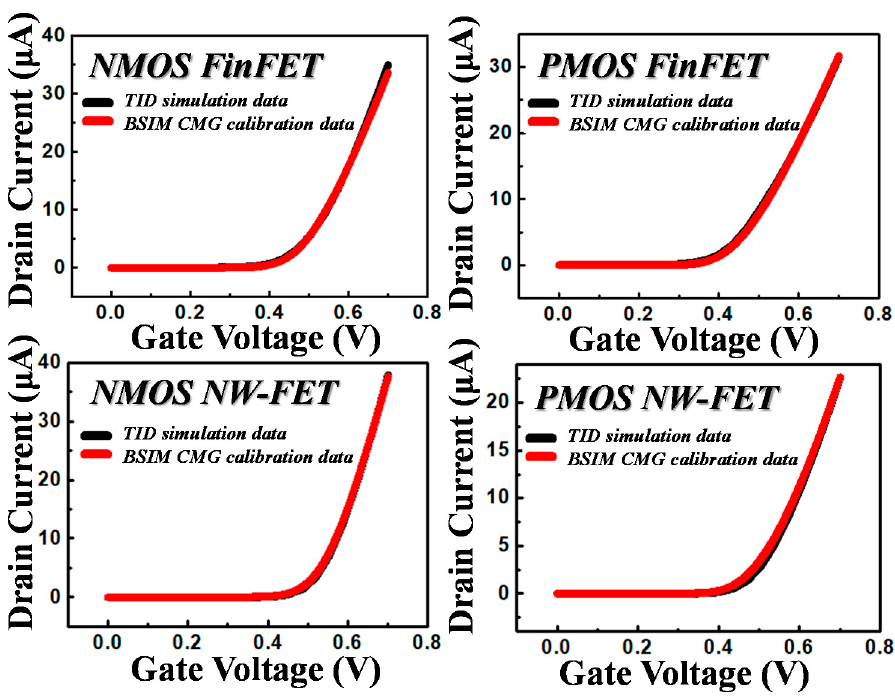
Figure 5. Calibration of the electrical characteristics of the FinFET and NW-FET with the Berkeley short-channel insulated-gate FET (BSIM) common multi-gate (CMG) parameters.